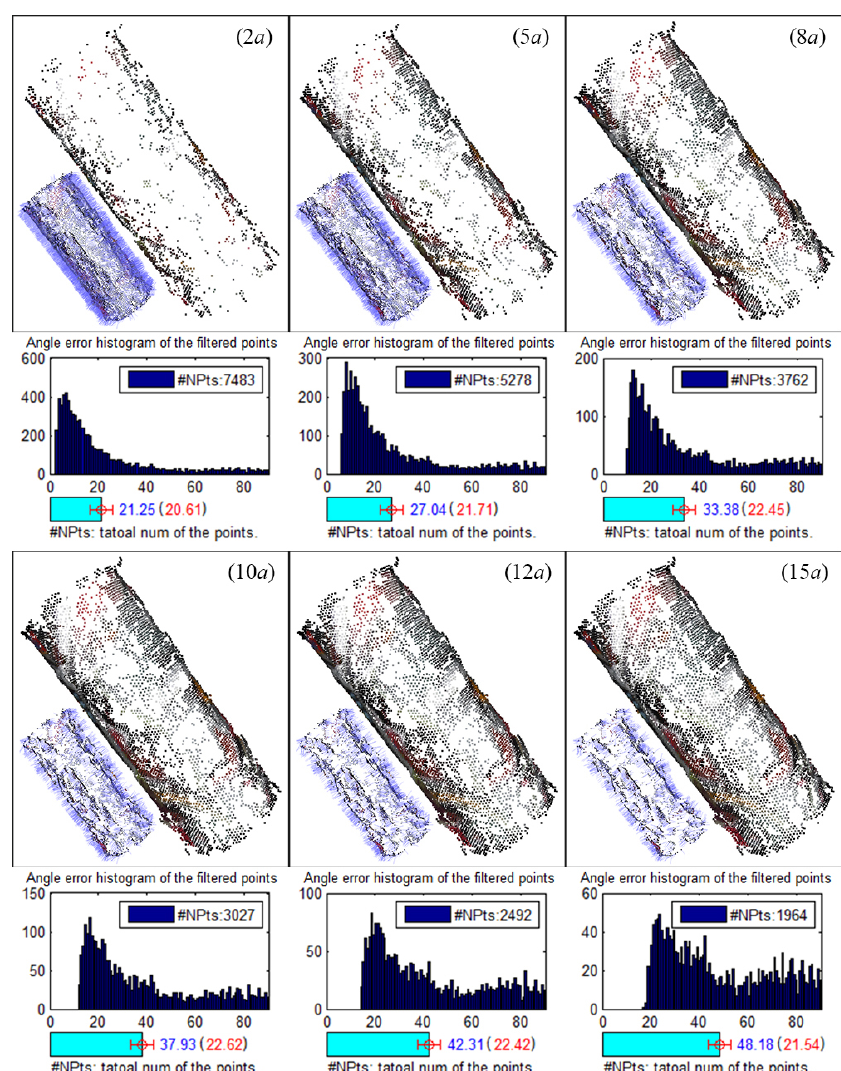
Figure 8. Results of rotationally-symmetric structure detection with different verification threshold d . Point clouds at the lower left corner, which are rendered with normals, are the points filtered out. The bar chart below the point cloud shows the histogram of the angle error of these filtered points, along with a horizontal bar indicating the average and